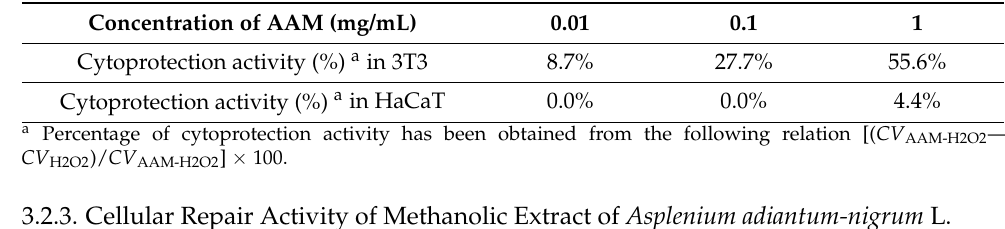
Figure 3. Cytoprotective activity of AAM in 3T3 ( A ) and HaCaT ( B ). Cells were incubated 24 h in the absence (white column) or in the presence of AAM (gray columns) and subsequently treated with 2 mM H 2 O 2 for 2.5 h and finally cell viability was determined by MTT assay and expressed as a percentage with respect to untreated cells. H 2 O 2 cell viability in absence of the extract was used as a positive control. Results are expressed as mean ± standard error of n = 3 (3T3) and n = 2 (HaCaT). A two-way analysis of variance (ANOVA) and a Bonferroni post hoc assay have been performed. Statistical differences were considered as follows: ** p ≤ 0.01 in comparison with positive control. Table 2. Cytoprotective activity of AAM on 3T3 and HaCaT cells.